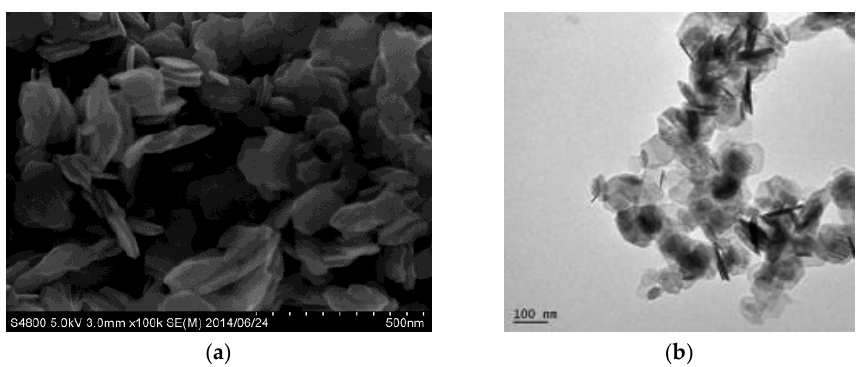
Figure 1. ( a ) SEM image of SnS 2 particles; ( b ) TEM image of SnS 2